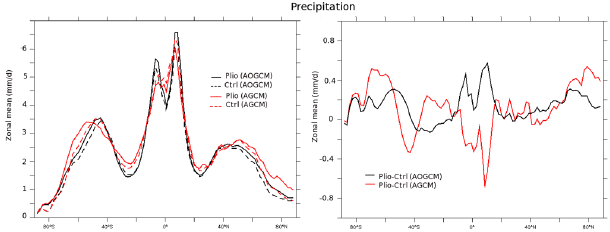
Fig. 10. Zonal annual mean precipitation for the control and the mid-Pliocene experiments (left). Zonal mean precipitation anomaly to the control for both Pliocene experiments